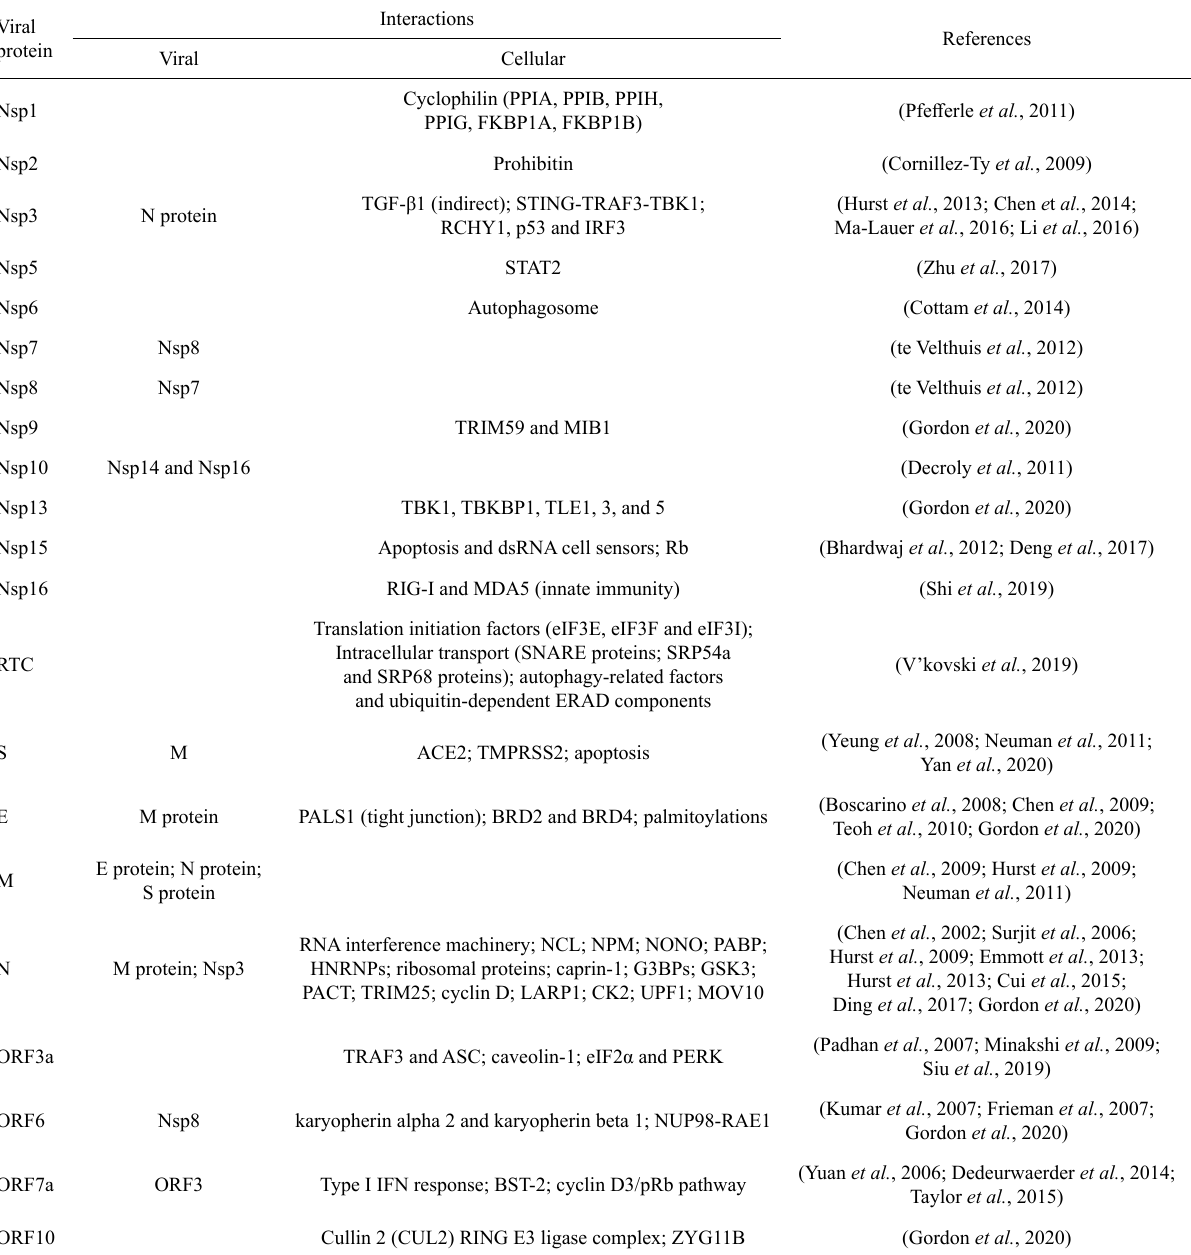
Table 2 – Interactions between coronavirus proteins and cellular proteins and/or pathways. Viral